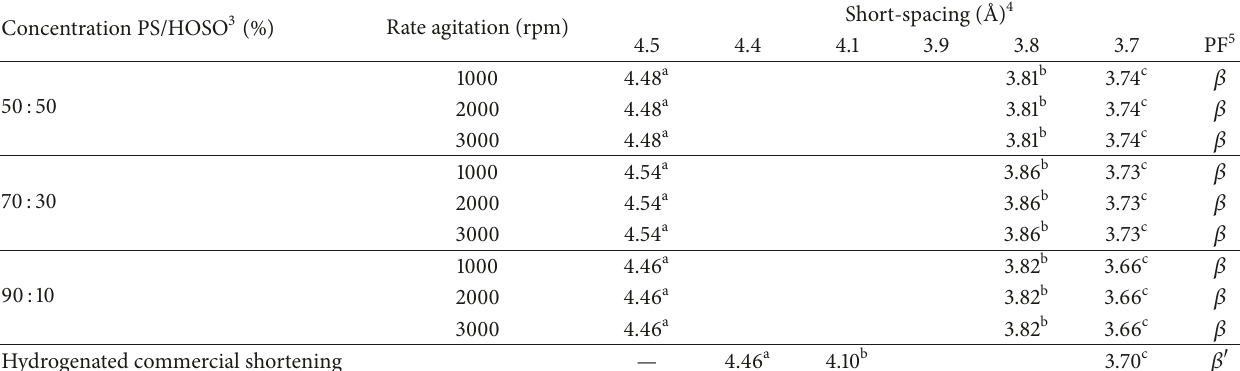
Hydrogenated commercial